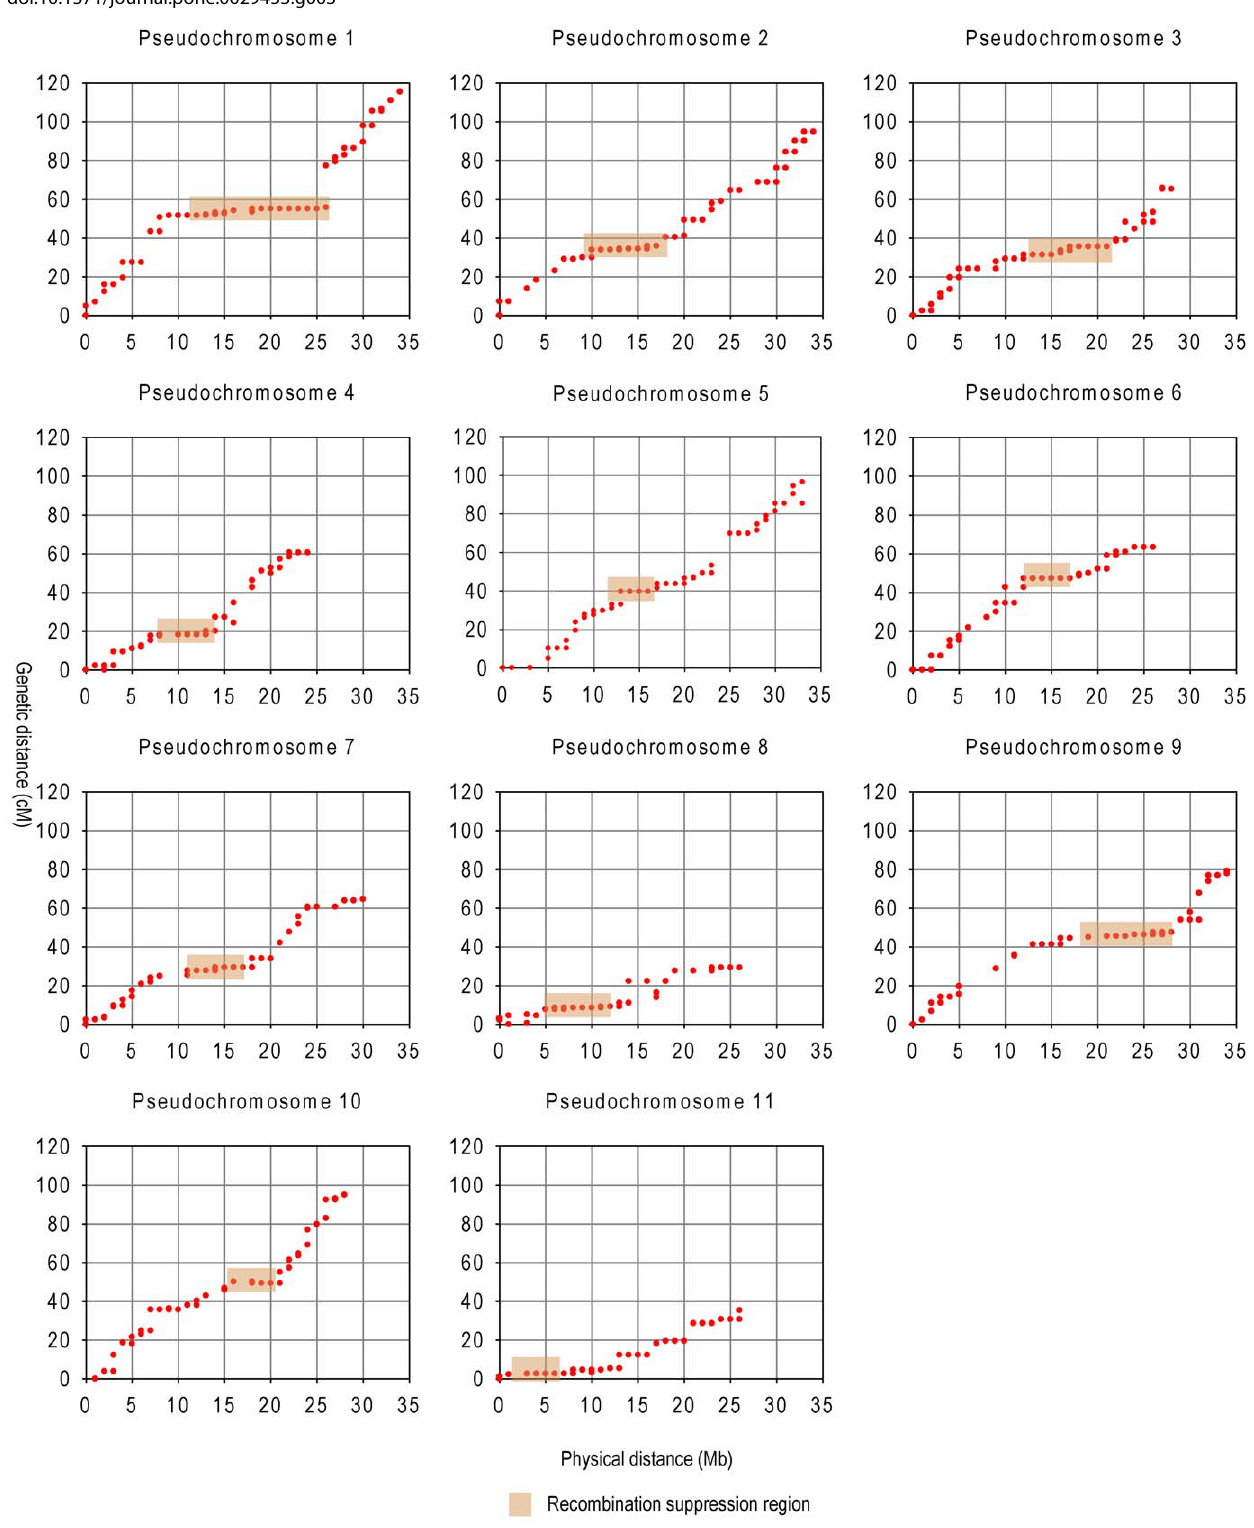
Figure 3. A high resolution linkage map for anchoring and orienting watermelon genome scaffolds. Bins and genetic distances in cM are listed on the left, scaffold lengths in Kb are listed on the right. Yellow scaffolds were oriented in forward direction, purple in reverse direction, and